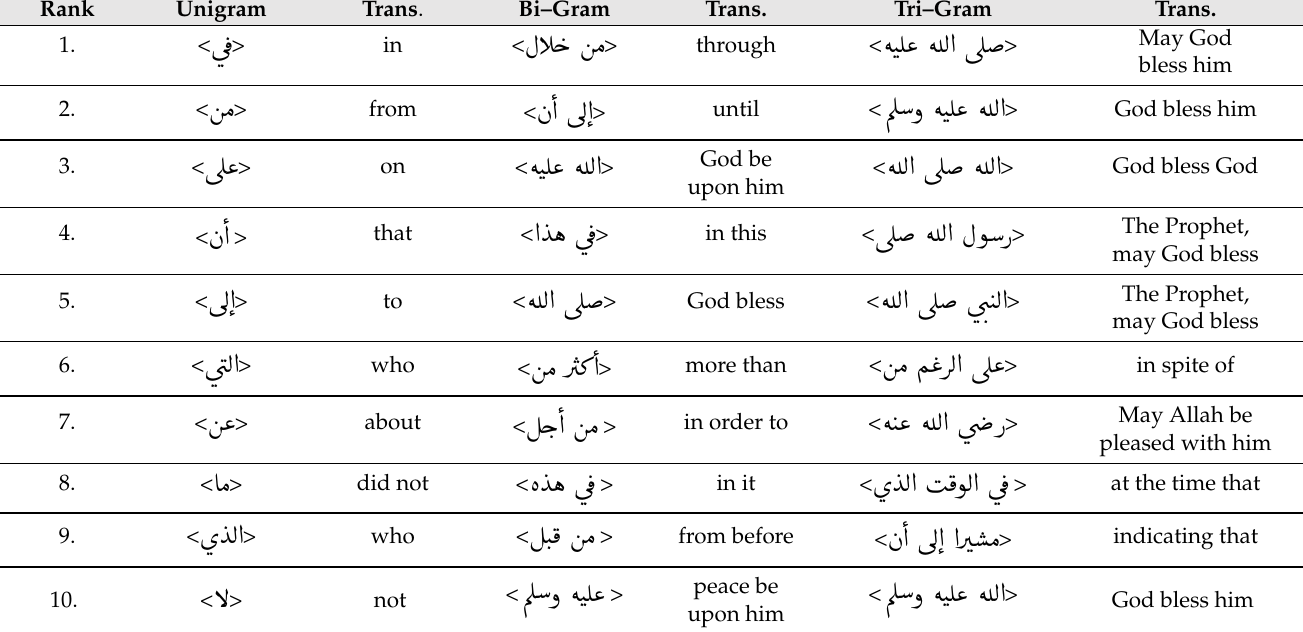
Table 4. The top ten unigram, bigram, and trigram in the Arabic Newspapers Corpus